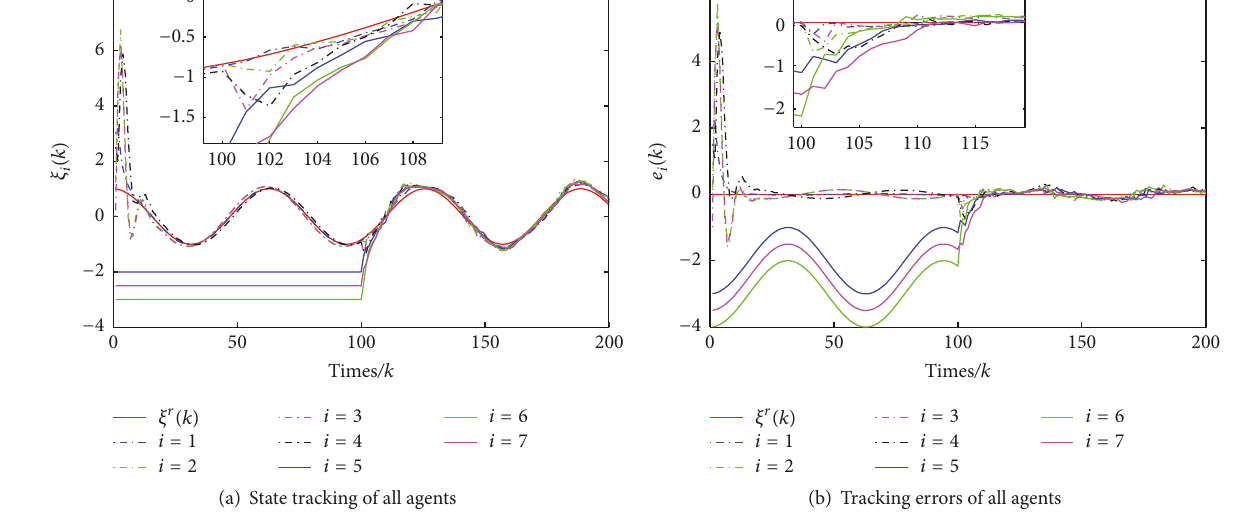
Figure 3: Simulation results in Case 1.